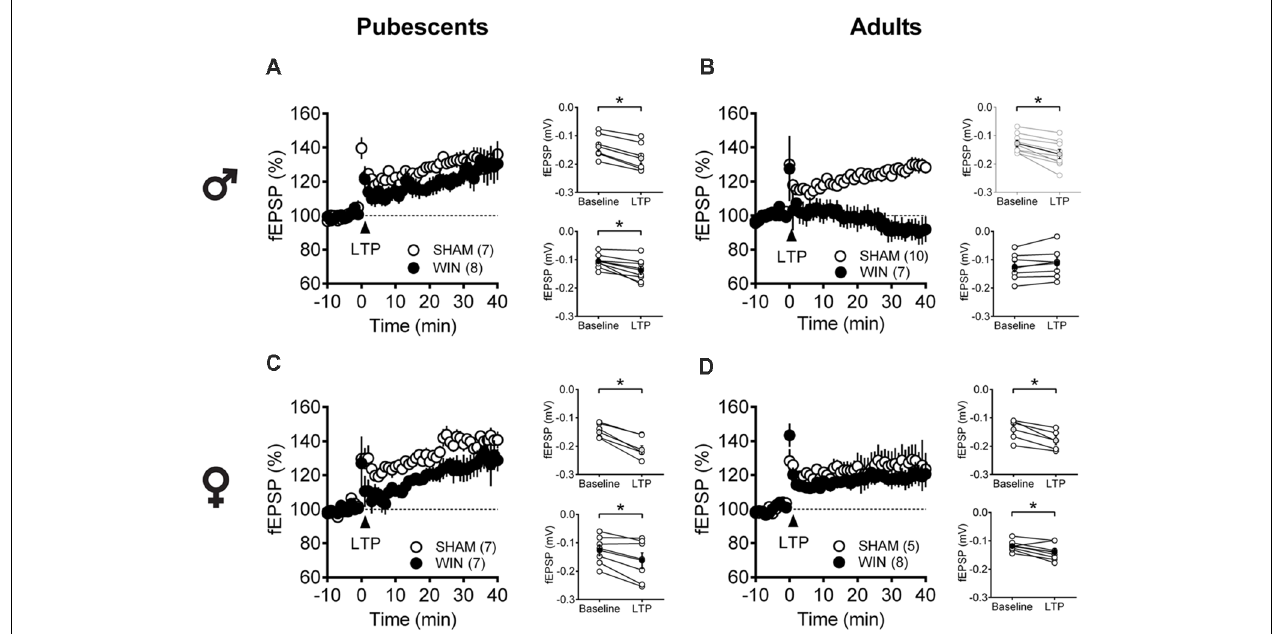
FIGURE 6 | Age- and sex-dependent ablation of long-term potentiation (LTP) in the rat PFC 24 h after in vivo cannabinoid exposure. Rats were exposed to WIN55,212-2 (WIN, 2 mg/kg, s.c.) 24 h before. Average time-courses of mean fEPSPs showing that theta-burst stimulation (indicated arrow) induced a LTP at mPFC synapses in both Sham- (white circles, n = 7) and WIN- (black circles, n = 8) exposed pubescent males (A) but not WIN-treated adults ( B , Sham: white circles, n = 10; WIN: black circles, n = 7). In contrast, LTP was present in mPFC slices obtained from both pubescent ( C , Sham: white circles, n = 7; WIN: black circles, n = 7) and adult ( D , Sham: white circles, n = 5; WIN: black circles, n = 8) WIN-treated females. Adjacent to the time-course figures are showed individual experiments (white circles) and group average (Sham, gray circles; WIN, black circles) before (baseline) and after (35–40 min) LTP induction showing that, in males, LTP is present in pubescent ( A , on the right) but not in adults ( B , on the right). In contrast, LTP was present in both pubescent ( C , on the right) and adult ( D , on the right) females previously treated with WIN. Error bars indicate SEM, n = individual rats, ∗ p < 0.05, Paired t -test. Males; Females. ♂ ♀